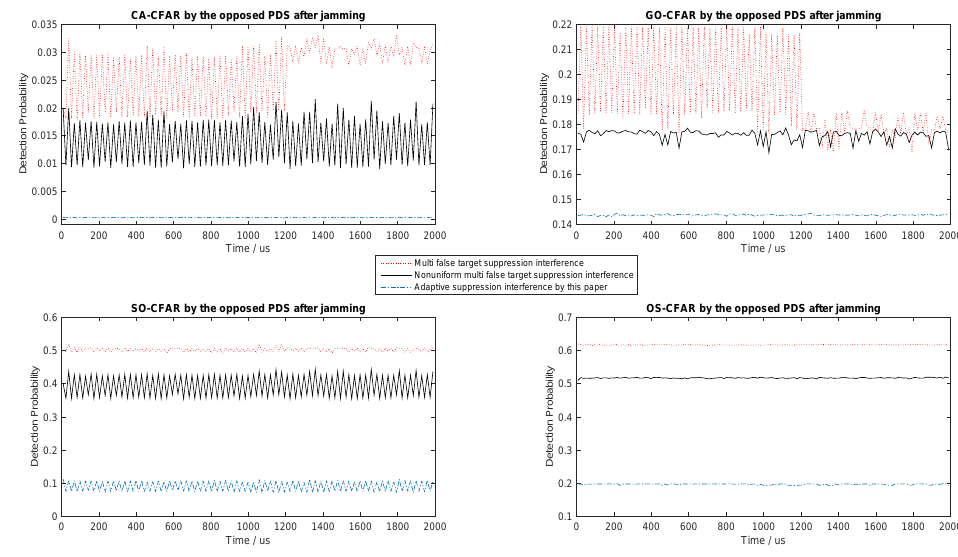
Figure 9. Compared to [31,32], detection probability of CA, GO, SO, and OS-CFAR before and after jamming when the number of reference units is 12.